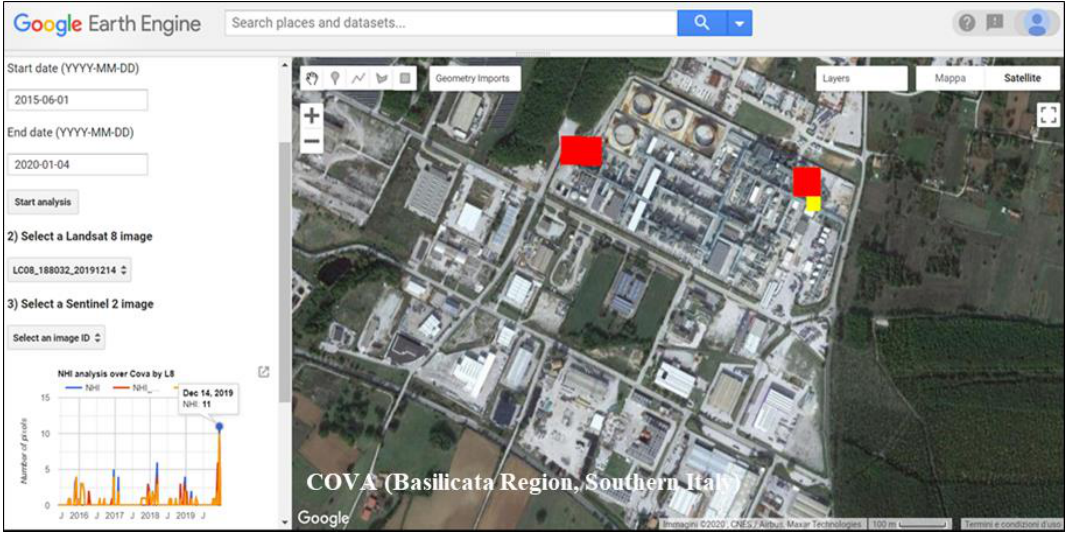
Figure 13. Preliminary implementation of the NHI algorithm on Landsat TM/ETM+ data, performed under the GEE platform; (a) Mount St. Helens ( 46°12′0.89″N 122°8′44.17″W ) activity investigated using Landsat-5 TM data of 1985 − 2010. On the right, thermal anomaly map of 14 October 2004; (b) Eyjafjallajökull (63°37 ′ 12 ″ N 19°36 ′ 48 ″ W) thermal activity of 1999 − 2014 analyzed using Landsat-7 ETM+ data. On the right, thermal anomaly map of 3 April 2010 generated using the same color code as Figure 3. In background the RGB imagery.